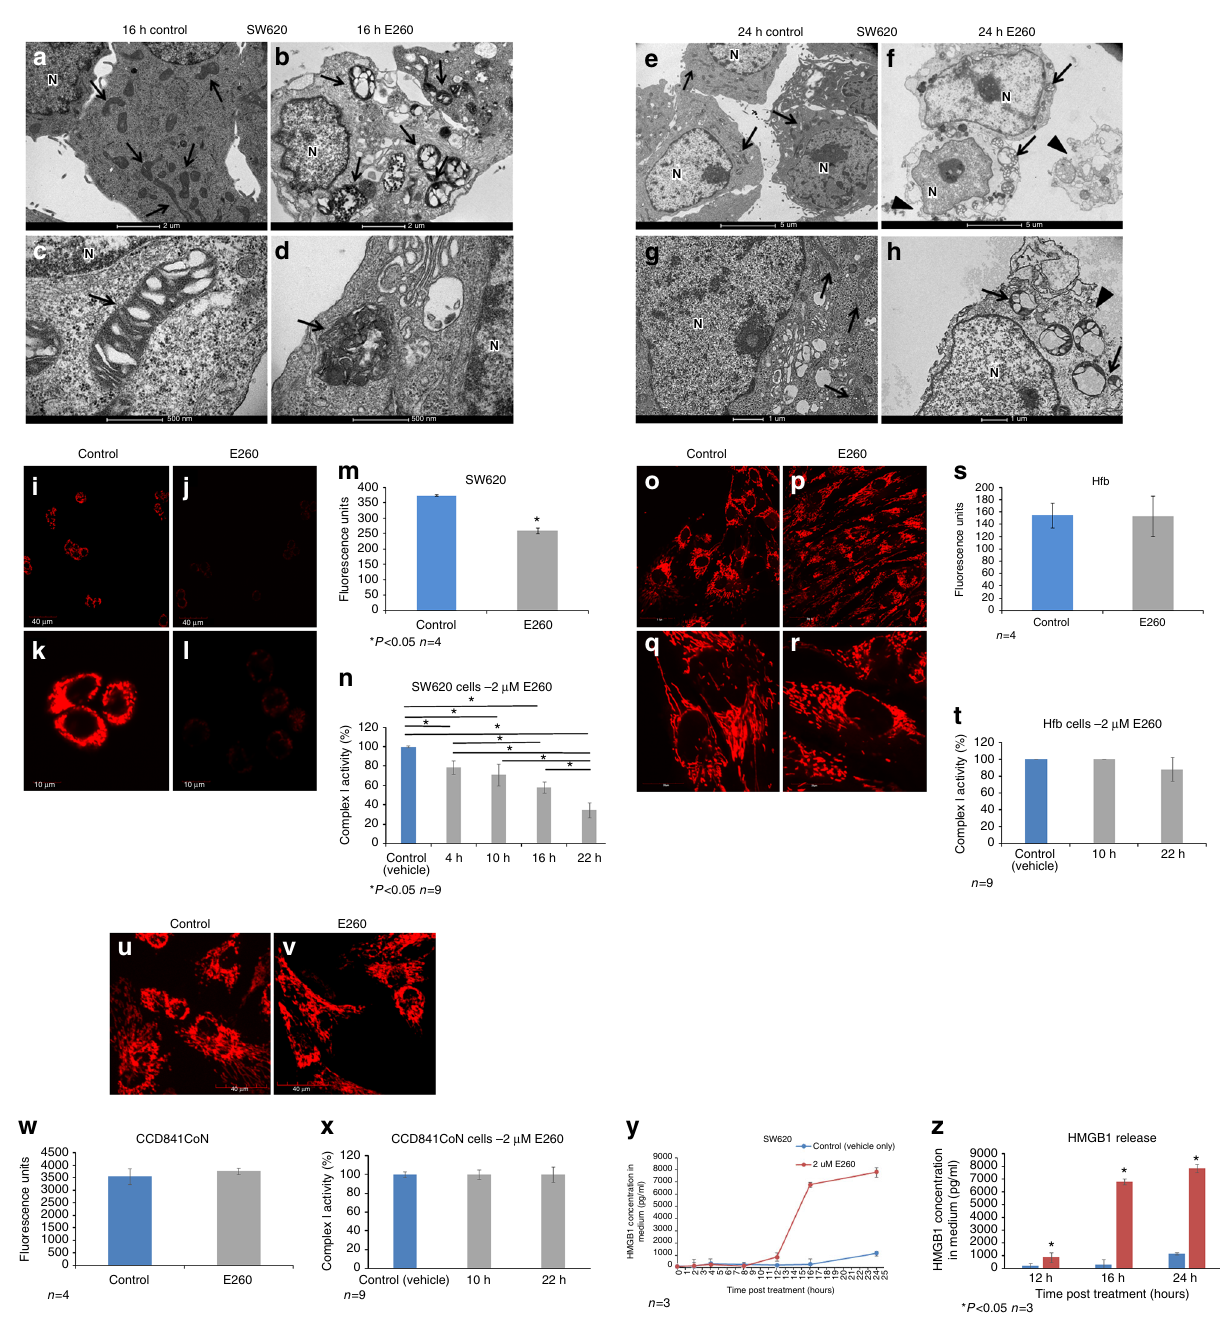
Fig. 3 E260 induces selective mitochondrial dysfunction and deformation, and necrotic death in CC cells. TEM analysis of SW620 cells treated with vehicle alone for 16 h ( a , c ) or 24 h ( e , g ), and cells treated with 2 µ M E260 for 16 h ( b , d ) or 24 h ( f , h ). Arrows indicate mitochondria. Arrow heads point to damaged cell membrane. Bars represent 2 µ m ( a , b , e , f ), 1 µ m ( g , h ), and 500 nm ( c , d ); N nucleus. MMP visualization by TMRE staining ( red ) in SW620 cells treated with vehicle ( i , k ), or with 2 µ M E260 ( j , l ) for 16 h. m ELISA quanti fi cation of SW620 MMP in control ( blue histogram ) and in cells treated with 2 µ M E260 ( gray histogram ) for 16 h; n = 4, ± SE. n Complex I activity in SW620 cells treated with 2 µ M E260 for increasing periods of time; n = 9, ± SE. MMP visualization by TMRE staining ( red ) in Hfb cells either treated with the vehicle ( o , q ) or with 2 µ M E260 ( p , r ) for 16 h. s ELISA quanti fi cation of human fi broblast MMP in control ( blue histogram ) and E260 ( gray histogram ) treated cells; n = 4, ± SE. Bars represent 40 µ m ( i , j , o , p ) and 10 µ m ( k , l , q , r ). t Complex I activity in Hfb cells treated with 2 µ M E260 for increasing periods of time; n = 9, ± SE. MMP visualization by TMRE staining ( red ) in CCD841CoN cells either treated with the vehicle ( u ) or with 2 µ M E260 ( v ) for 16 h. w ELISA quanti fi cation of CCD841CoN MMP in control ( blue histogram ) and E260 ( gray histogram ) treated cells; n = 4, ± SE. x Complex I activity in CCD841CoN cells treated with 2 µ M E260 for increasing periods of time; n = 9, ± SE. y Quanti fi cation of the HMGB1 concentrations in CC cells growth medium following treatment with control solution or 2 µ M E260 for different periods of time. n = 3, ± SE. z HMGB1 concentrations in CC cells growth medium 12, 16, and 24 h post treatment with control ( blue histograms ) or E260 ( red histograms ) as in y , with comparative statistical tests. n = 3 ± SE